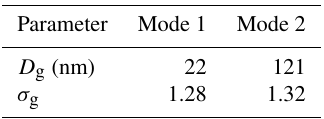
Table 1. Size distribution input data – geometric mean diameter ( D g ) and geometric standard deviation ( σ g ).